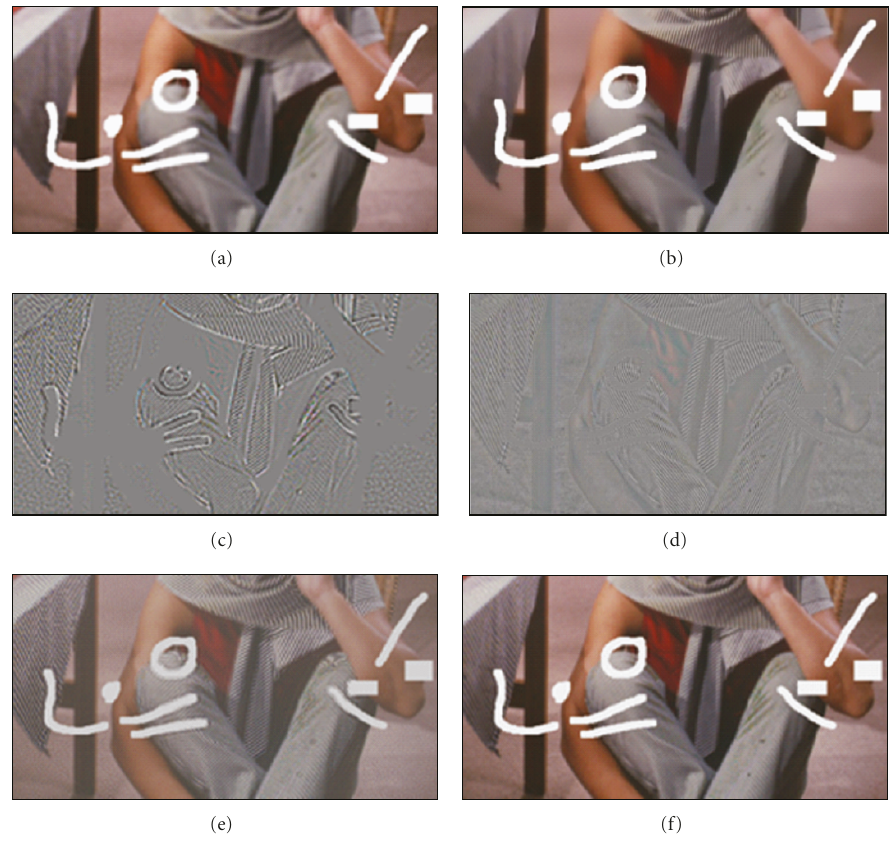
Figure 4: Chosen parts of decomposed components of the input image and the output images: the geometry images (a) and (b) and the tex- ture images(c) and (d), and the output images(e) and (f)are obtained by the method in [19] (left side) and the proposed method (right